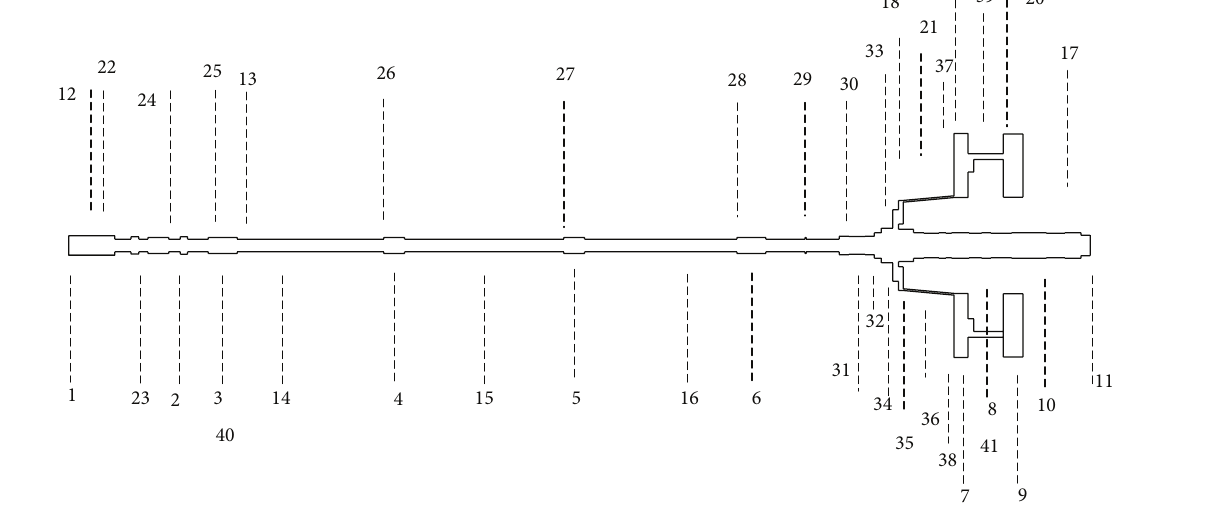
Figure 5: Finite element model of the power turbine rotor.